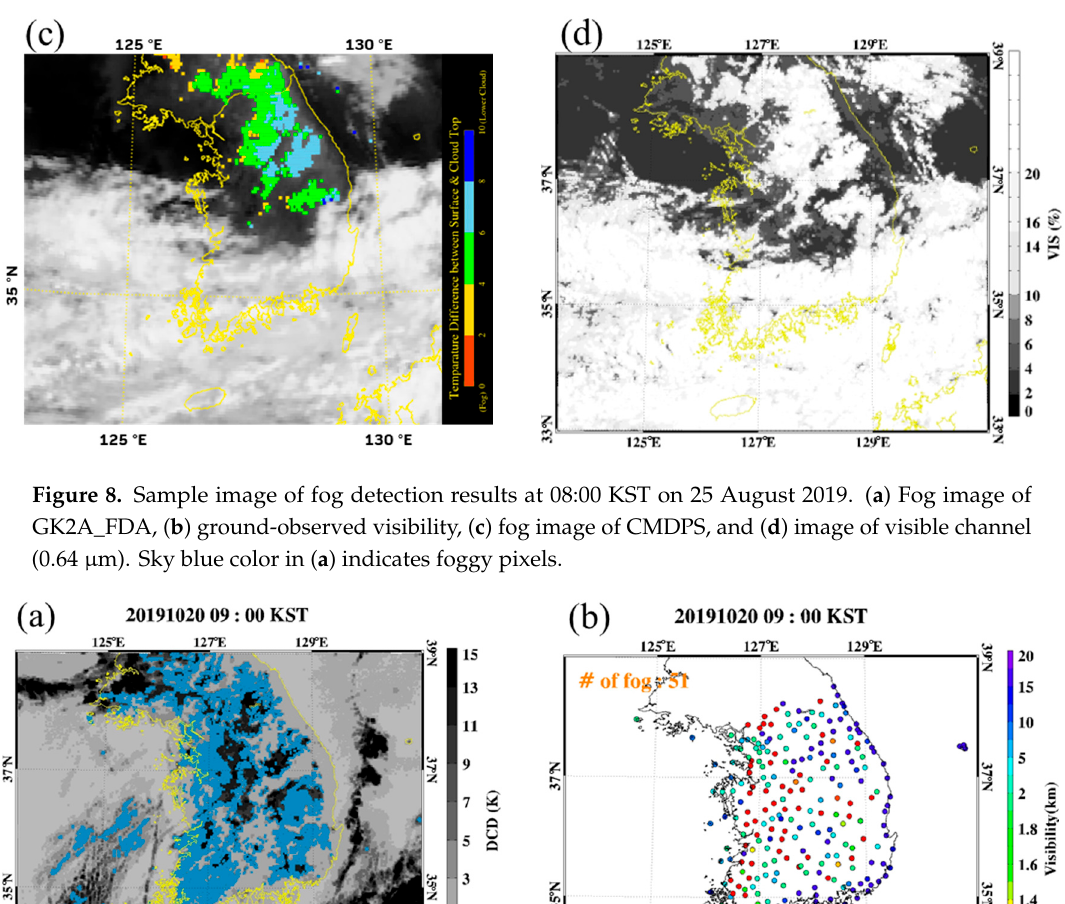
Figure 8. Sample image of fog detection results at 08:00 KST on 25 August 2019. ( a ) Fog image of GK2A_FDA, ( b ) ground-observed visibility, ( c ) fog image of CMDPS, and ( d ) image of visible channel (0.64 μ m). Sky blue color in ( a ) indicates foggy pixels.